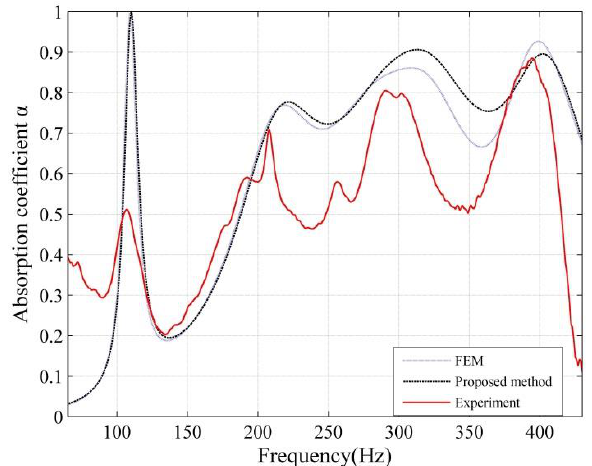
Figure 6. Measured and calculated sound absorption coefficients of the shunted loudspeaker array.